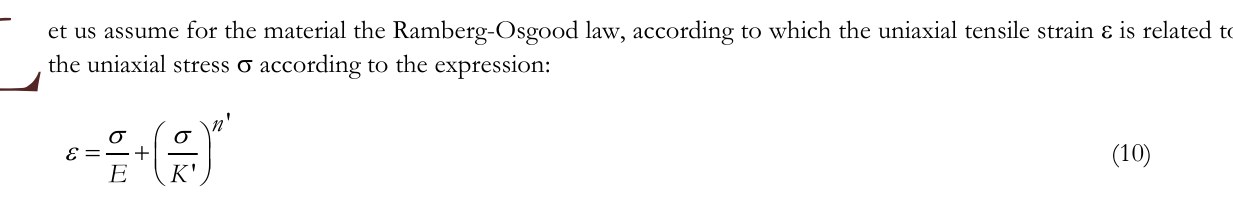
L IMITATIONS TO THE LINEAR ELASTIC